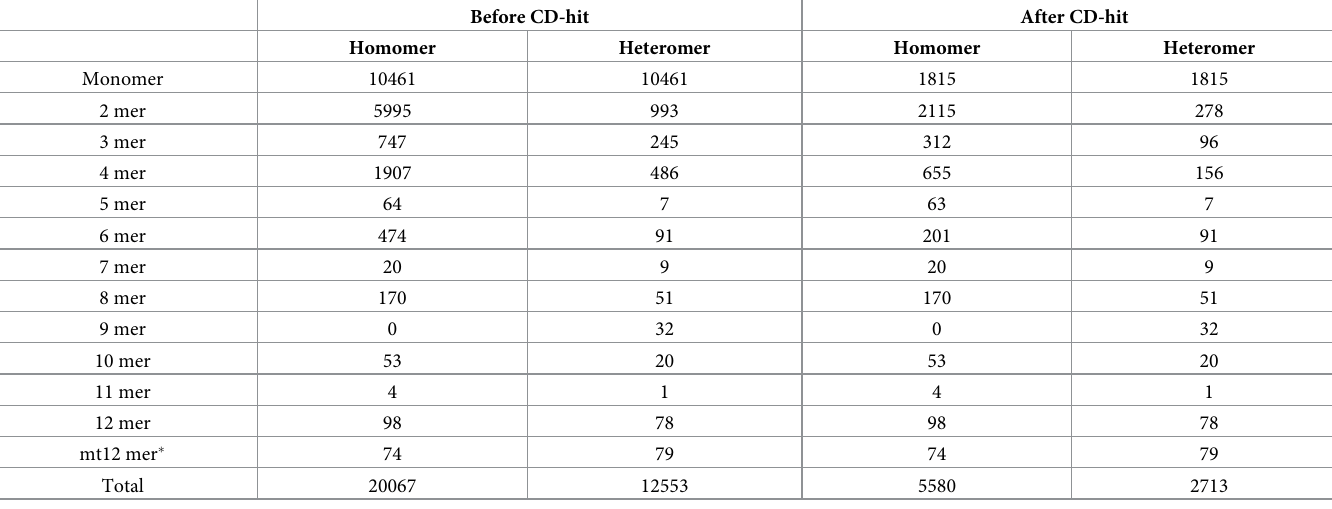
Table 1. Data numbers of each subunit before and after CD-Hit